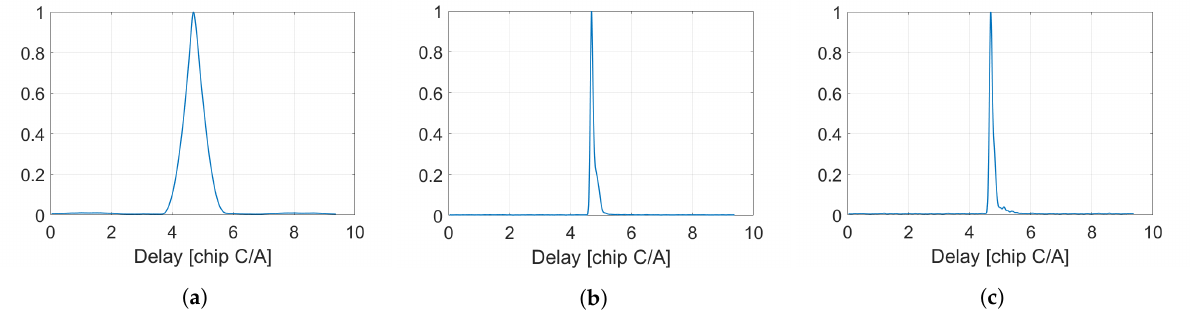
Figure 13. Examples of normalized reflected waveforms shapes acquired by MIR, showing ( a ) L1 waveform, ( b ) L5 waveform and ( c ) E5a waveform, all computed with cGNSS-R technique and with T coh = 1 ms and T incoh = 100